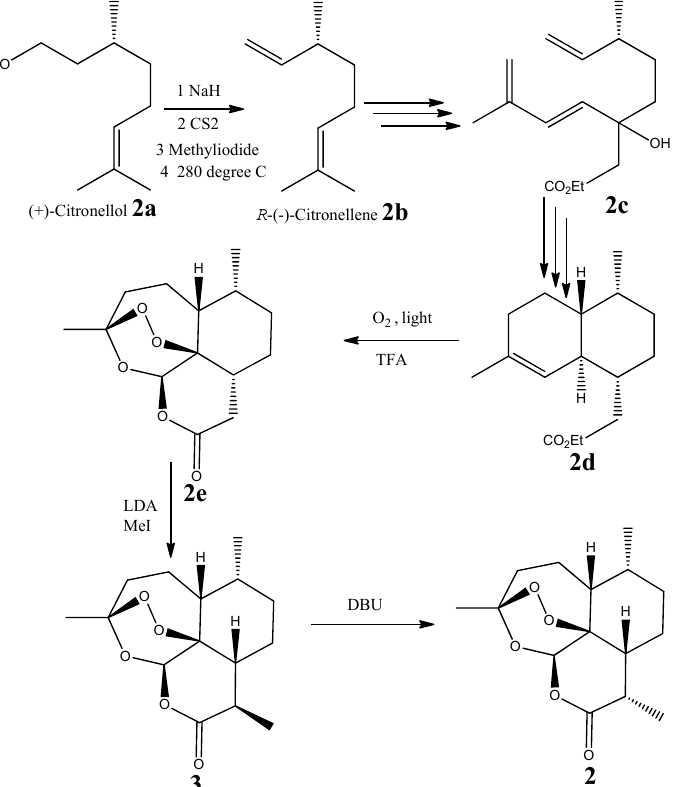
Figure 4. Chemical syntheses of compound ( 3 ) (epimer of compound ( 2 ) at C-9) and ( − )-6-epi-artemisinin ( 2 ).